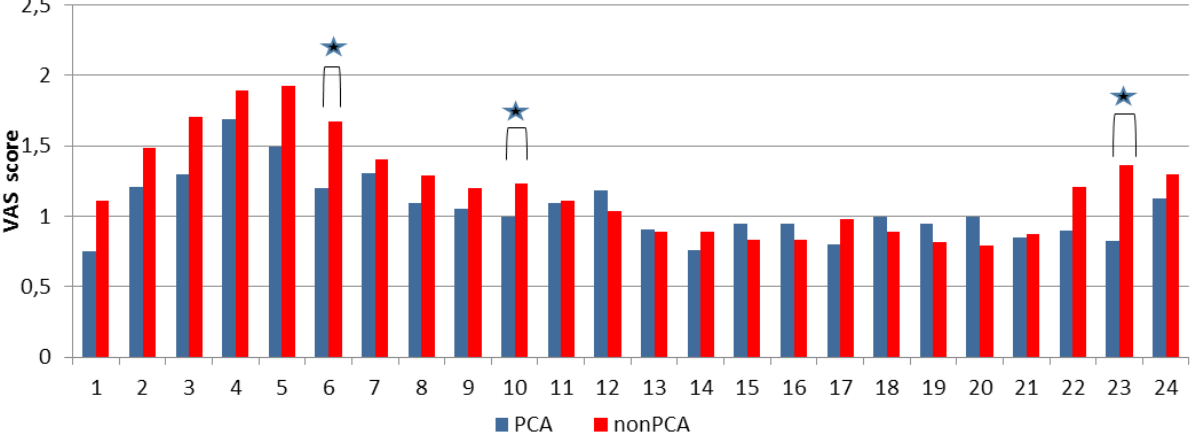
Fig. 4. Comparison of Visual Analogue Scale scores during first 24 h after surgery between the PCEA and non-PCEA group. PCEA, patient-controlled epidural analgesia; non-PCEA, (conventional) non-patient-controlled epidural analgesia; VAS, Visual Analogue